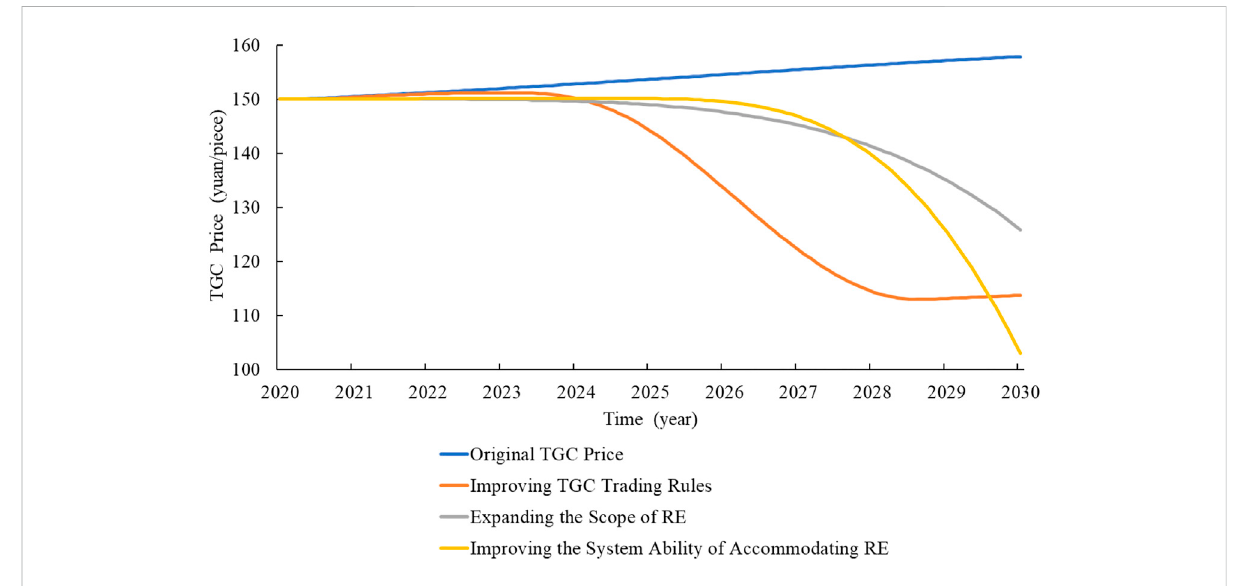
FIGURE 7 TGC prices under different